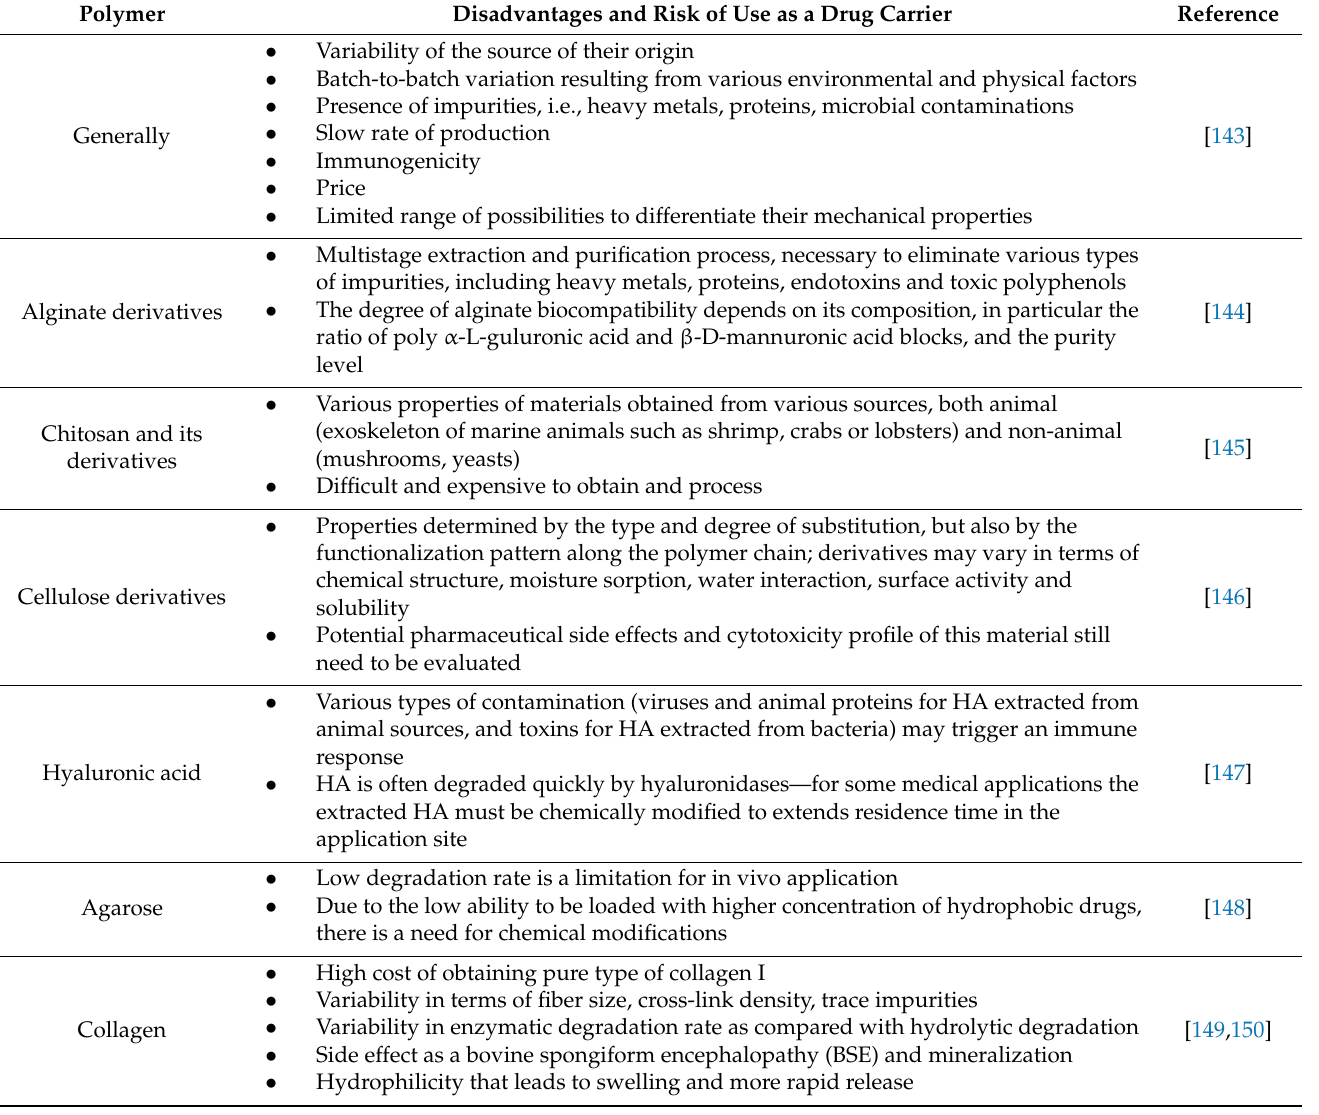
Table 2. Summary of disadvantages and possible risks posed by natural